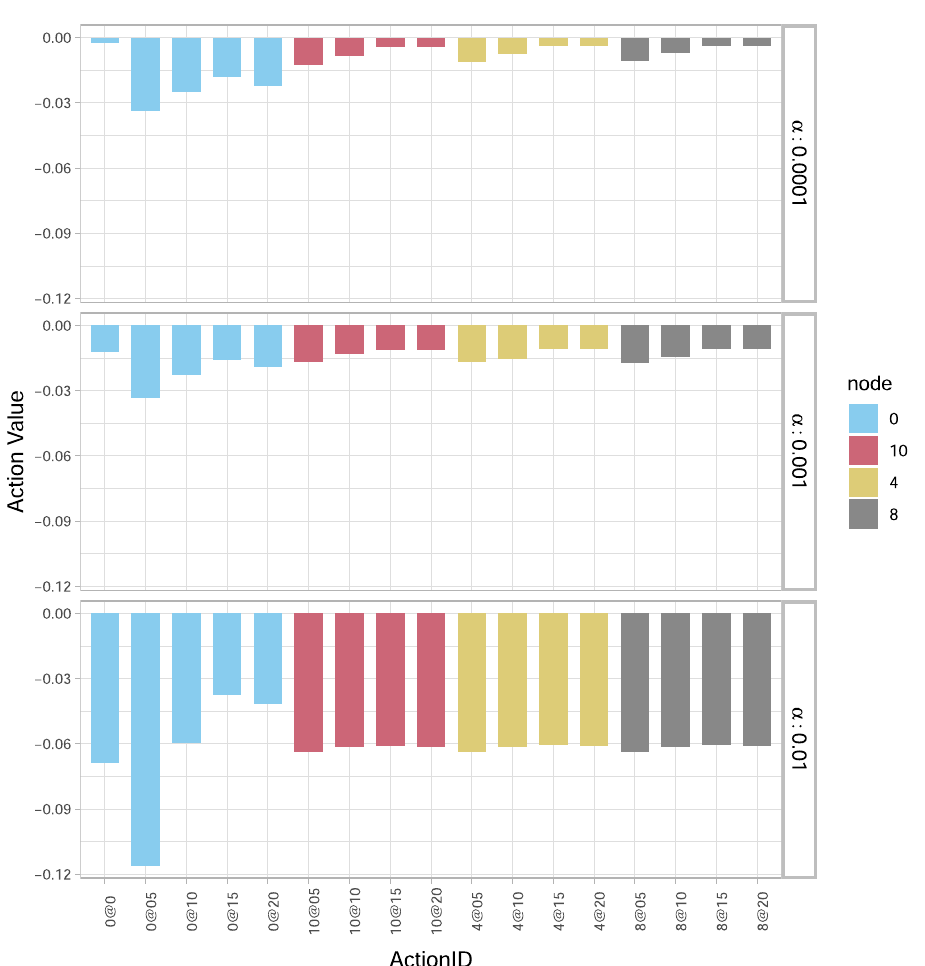
Fig. 2| Optimalactionvaluefunction Q * fortheKrackhardt Kite(KK)network. The optimal action value function Q * ( s 0 , a 0 ) at time 0 for different actions a 0 (a governmentinvestmentof0,0.5,1,1.5or2intheequityofthenodes)andvaluesof percentage wealth loss upon default α (0.0001, 0.001 and 0.01). In the legend,the coloursidentifythenodes{0,10,4,8}inthe fi gure(0representsallnodes).Onthe x axis, the ActionID 0@0 means no investment, 0@05 means investing 0.5 in all the nodes, 10@05 means investing 0.5 in node 10, etc.For a small value of α =0.0001,